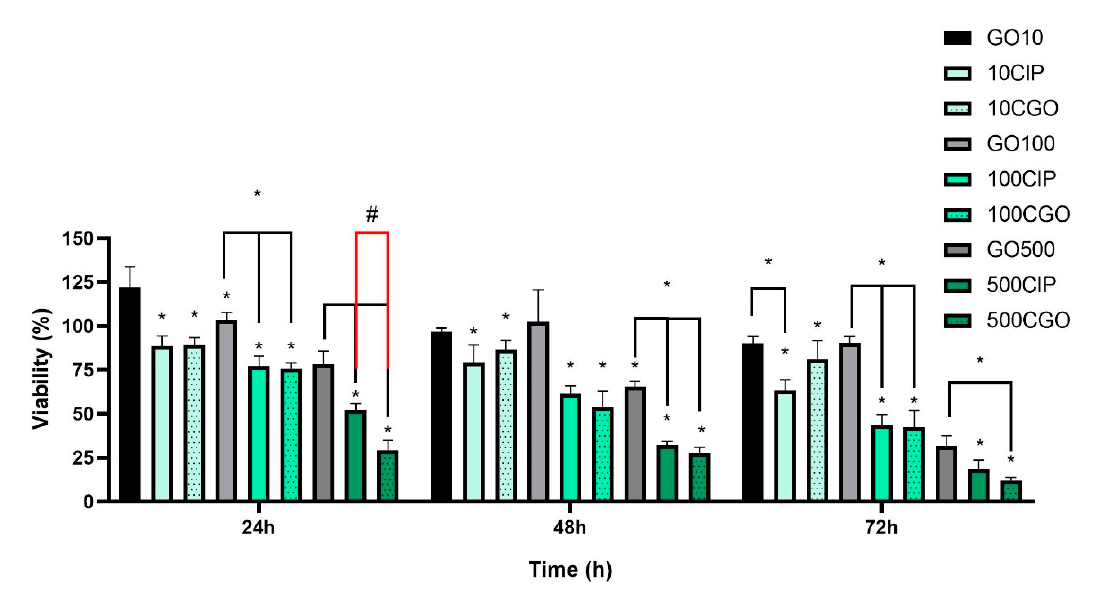
Figure 4. Results of the MTT assay for the T24 cell line in the following exposition times from the start of incubation with the addition of ciprofloxacin and ciprofloxacin modified from the 10–500 µ M concentration range. Statistically significant di ff erences compared to the control marked as “*” above the averages on the graph. Statistically significant di ff erences between variants marked as “*” above a clamp ( p < 0.05). “#”—statistically significant di ff erence between the corresponding concentrations of ciprofloxacin and modified ciprofloxacin ( p < 0.05). An additional experiment was performed using controls that contained the solvents used with the tested compounds, i.e., deionized water and PBS at concentrations correlating to those present at the studied solutions. There was no significant di ff erence in cell viability with those tested solvents compared to control (results not shown).